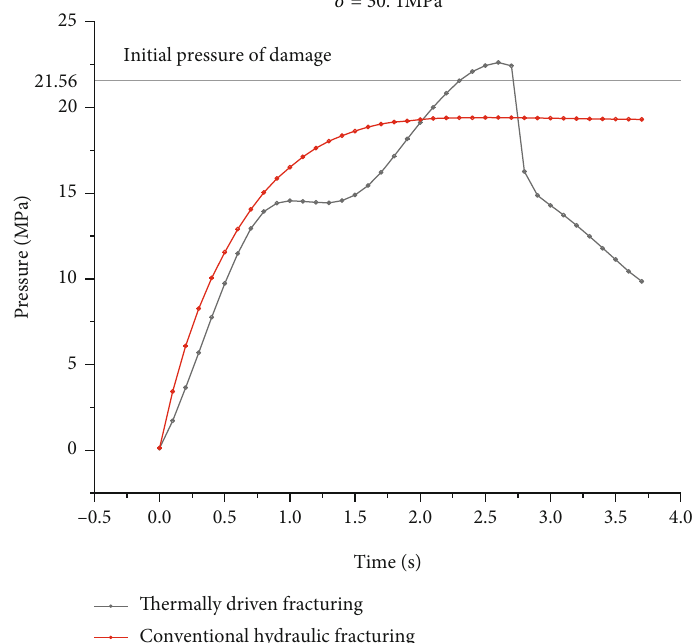
Figure 18: Pressure variation curves of thermally driven fracturing and hydraulic fracturing for a rock tensile strength of